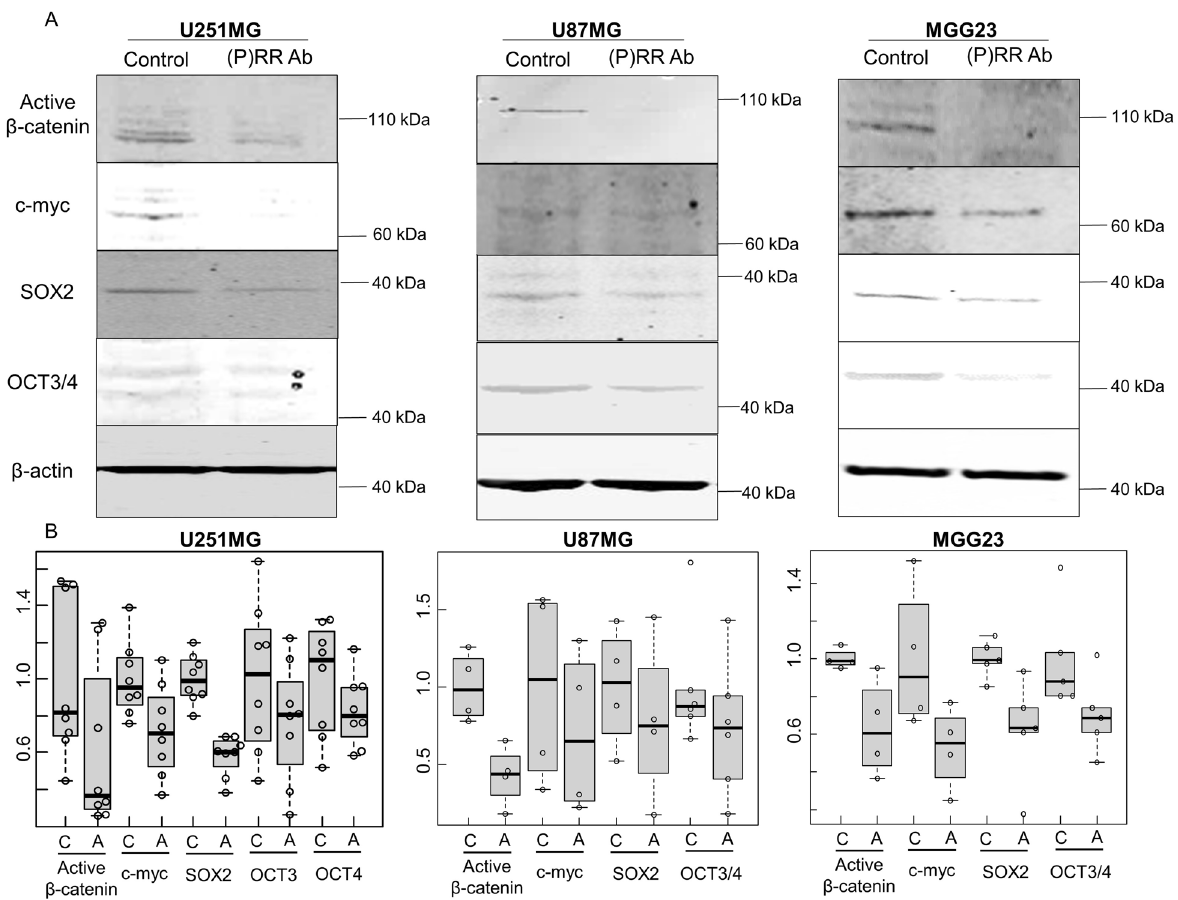
Figure 2. Effect of the (P)RR Ab on Wnt signaling and stemness markers. Using Cells were treated with the (P)RR Ab at 400 µg/mL. ( A ) Representative western blot images showing that treatment with the (P)RR Ab reduced the activity of the Wnt/β-catenin signaling pathway [active β-catenin and c-myc] and expression of stemness markers (SOX2 and Oct3/4) in U251MG, U87MG and MGG23 cells. Original blots are presented in Supplementary Fig. S5. ( B ) Relative protein levels measured using western blotting, quantified and normalized to β-actin levels. C control, A